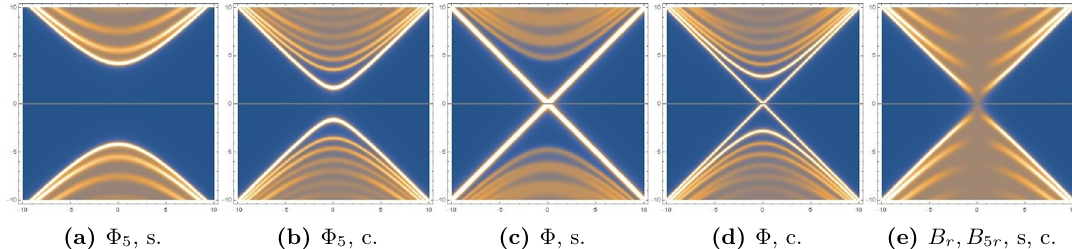
Figure 7. Spectral Function(SF) (a,b) with parity breaking scalar. (a) with source only. Gap √ ∆ ∼ M 05 . (b) with condensation only, ∆ ∼ M 5 ; (c,d) with parity invariant scalar. Notice the zero modes. (c) source only (d) condensation only. (e) B r , B rt shows the spectrum of zero coupling due to the gamma matrix structrure.